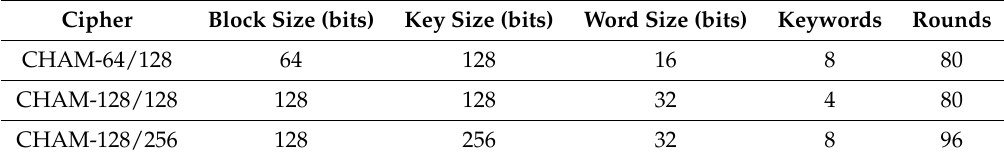
Table 3. Parameters of CHAM.